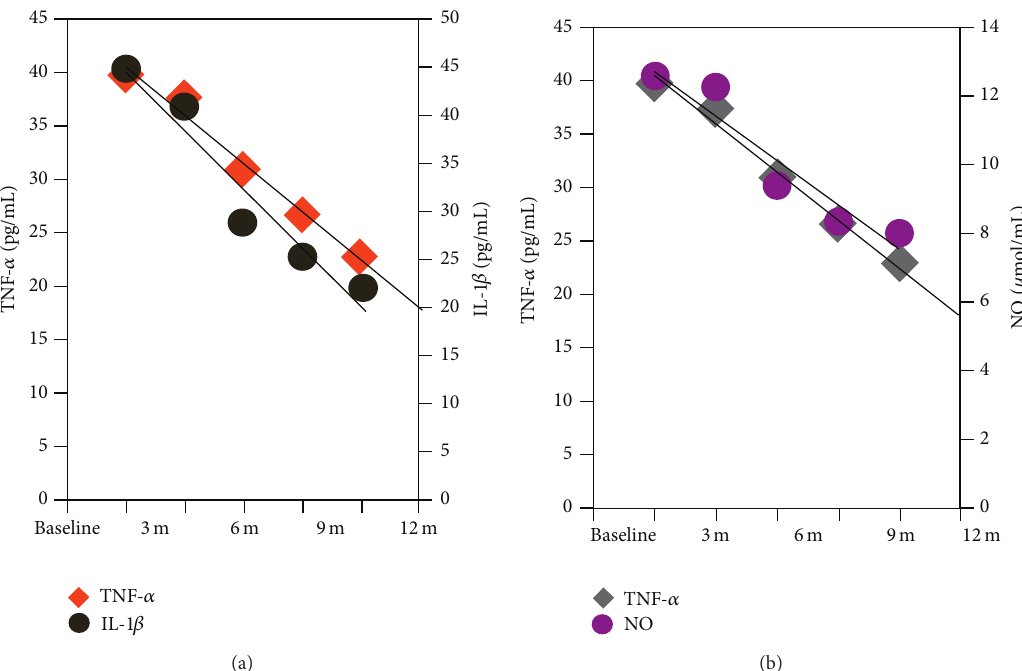
Figure 1: Cytokines and oxidative stress marker reduction in multiple sclerosis patients. (a) Correlation plot between TNF 𝛼 and IL-1 𝛽 serum levels. (b) Correlation plot between TNF 𝛼 and nitric oxide (NO) catabolites. Pearson correlation coefficients were calculated for all data sets: IL-6 𝑅 2 = 0.9585 , TNF 𝛼 𝑅 2 = 0.9844 , IL-1 𝛽 𝑅 2 = 0.9391 , NO 𝑅 2 = 0.9068 . Modified from Rodr´ıguez-Rodr´ıguez V. (2013) PhD, thesis, University of